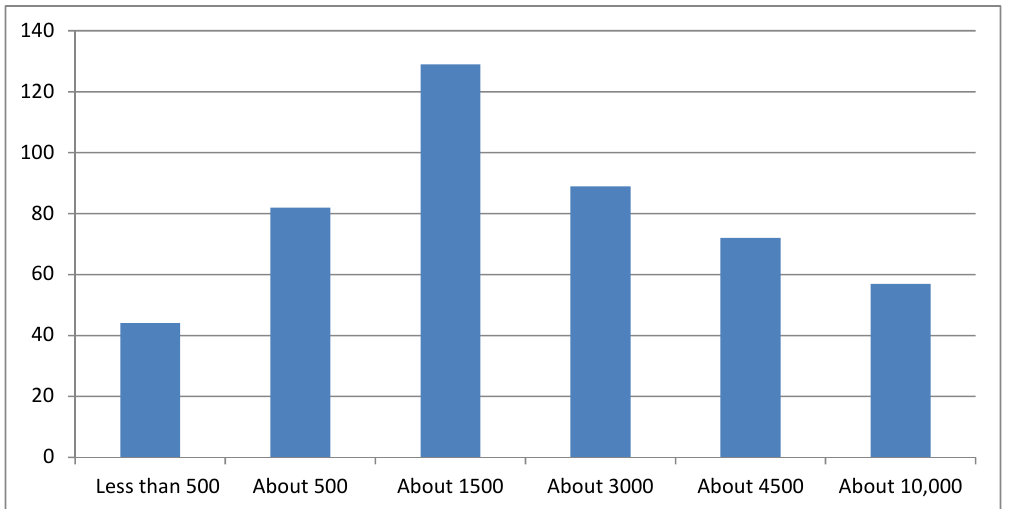
Figure 2. Answers related to cases of OSCC per year in Italy.